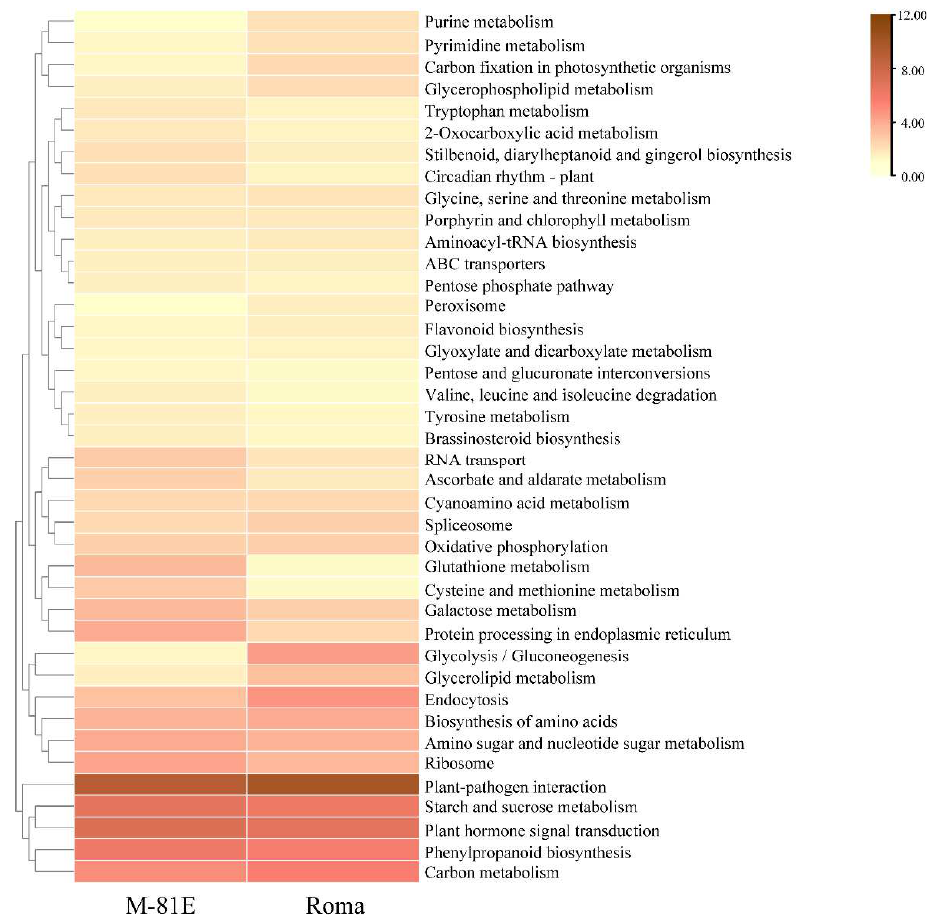
Figure 4. The heat map display of DEGs assigned to different KEGG pathways.